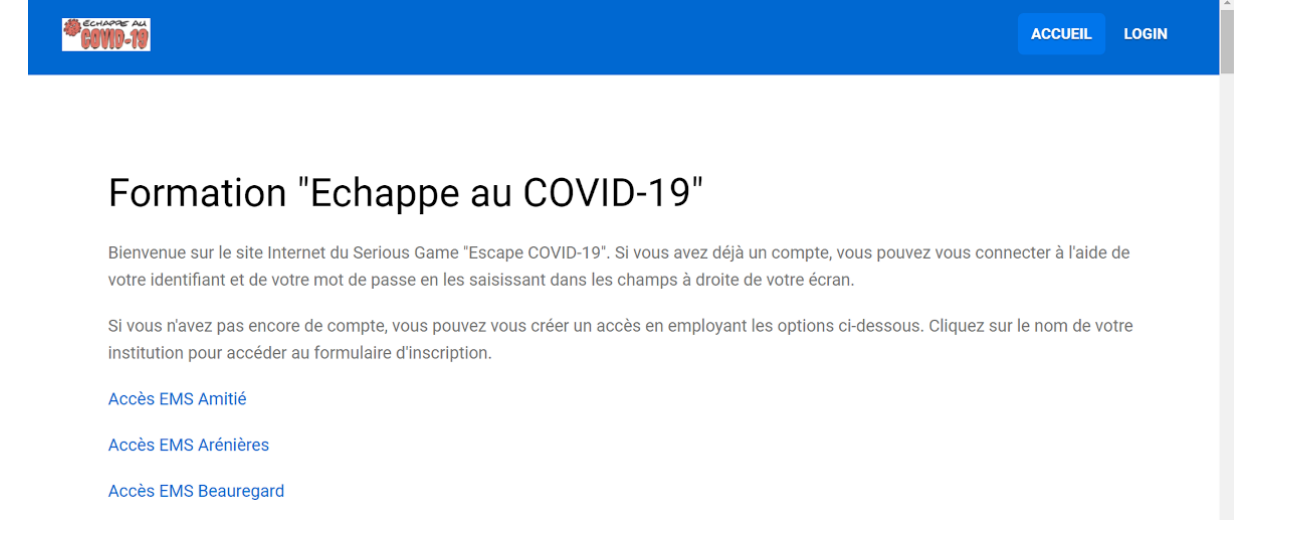
Figure 2. Front page of the study website (in French). Only the first three long-term care facilities are displayed.